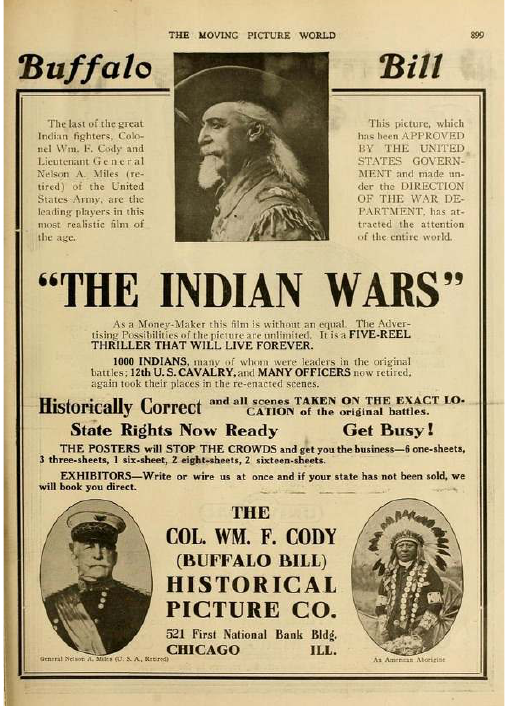
Figure 1. Ad printed in The Moving Picture World claiming The Indian Wars was “historically